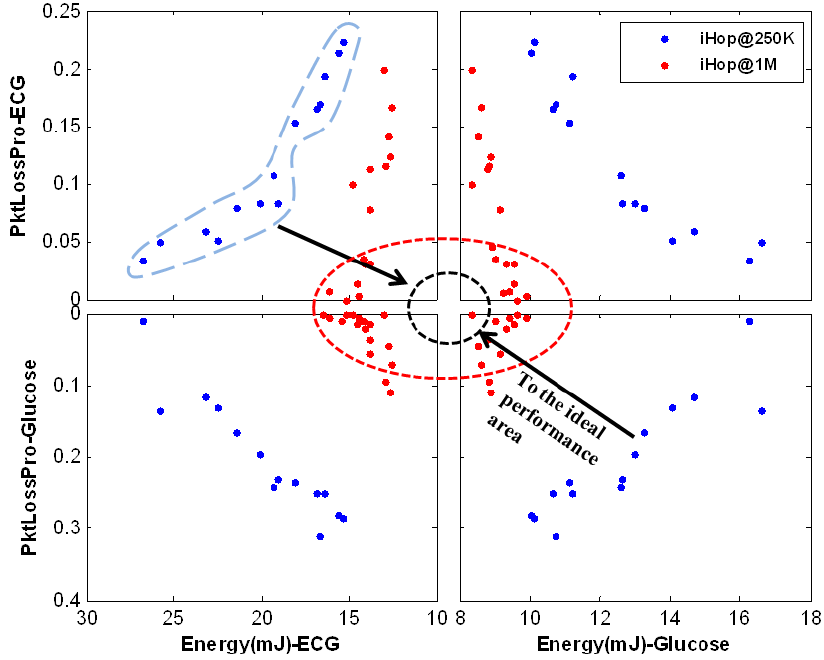
Figure 9. Energy and packet loss Pareto front (ECG vs. Glucose 1 Mb and 250